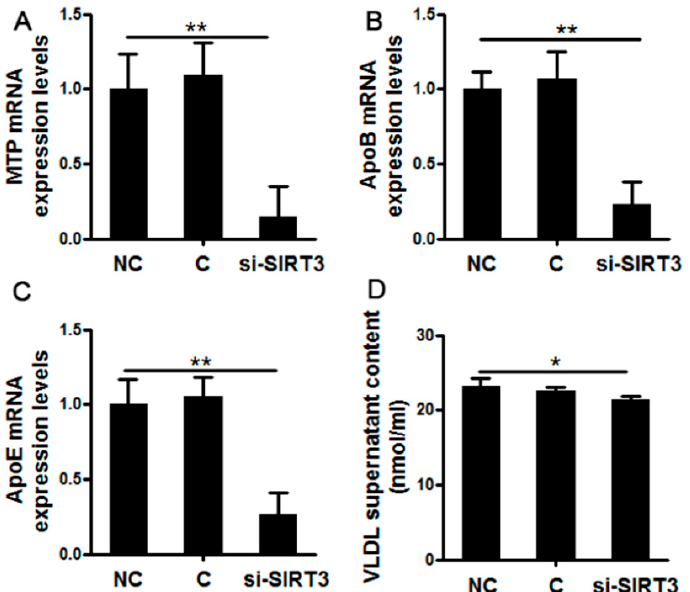
Figure 2. Effects of SIRT3 silencing on the synthesis and secretion of Very Low-Density Lipoprotein (VLDL) in cow hepatocytes. Primary cow hepatocytes were treated with si-SIRT3 by the lipofectamine 2000 regent for 6 h. Hepatocytes treated with si-RNA were used as the negative controls. After another 42 h of incubation with RPMI1640 medium, cells were harvested. The mRNA abundance of MTP ( A ), ApoB ( B ), and ApoE ( C ) were measured by qRT-PCR. The VLDL content in supernatants was measured by a commercial kit ( D ). NC, negative controls; C, blank controls; si-SIRT3, si-SIRT3 treatment group. For all bar plots shown, data are expressed as the mean ± SEM. * indicates p < 0.05; ** indicates p < 0.01 by the one-way ANOVA with Bonferroni correction. Results are representative of at least three independent measurements.